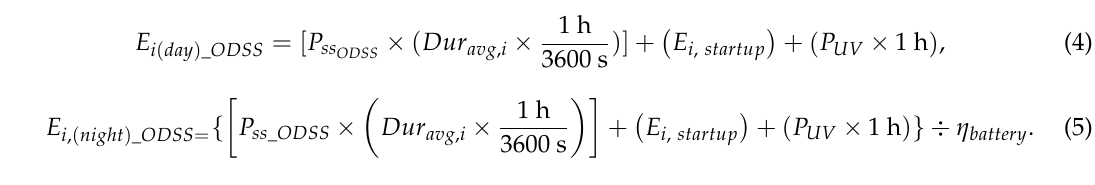
Table 1. Parameters for Equations (4) and (5) specifying parameter, symbol used, value and units used. Parameter Symbol Value Unit Pump Steady State Power per hour P ss _ ODSS 0.56 kW Average Duration per hour Dur avg , i Based on REU2016 Data seconds Pump Startup Energy per hour E i , startup Determined from Equation (2) kWh Power Consumption of UV lamp for 1 hour P UV 0.060 kWh Battery Round-Trip Efficiency η battery 0.89